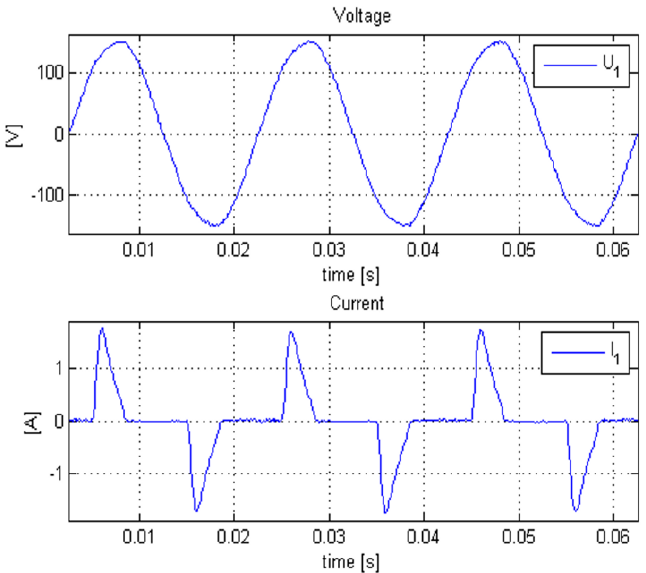
Figure 3. Three period (60 ms) acquired at a sampling frequency of 80 kHz: ( top )—voltage; ( bottom )— current [16].